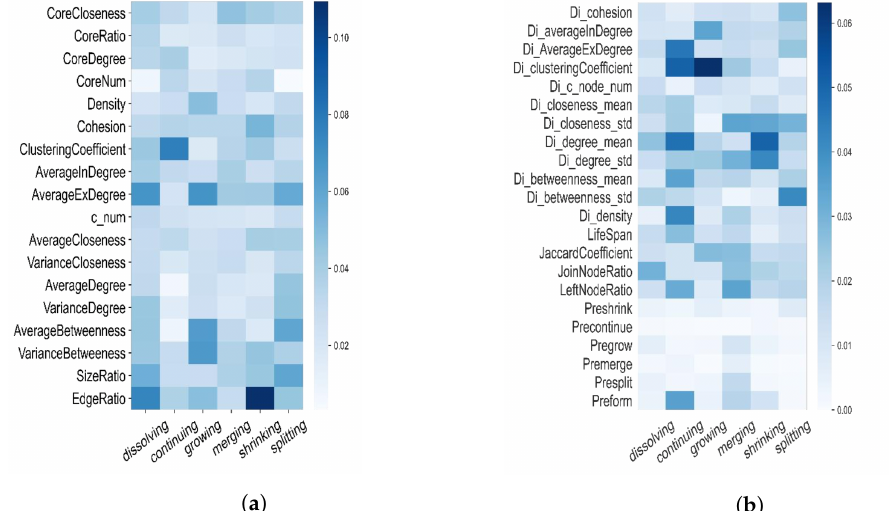
Figure 4. Distribution of the importance of each feature in the Bitcon data set: ( a ) Core node features and Community structural features; ( b ) Community sequential features and Community behavior features.